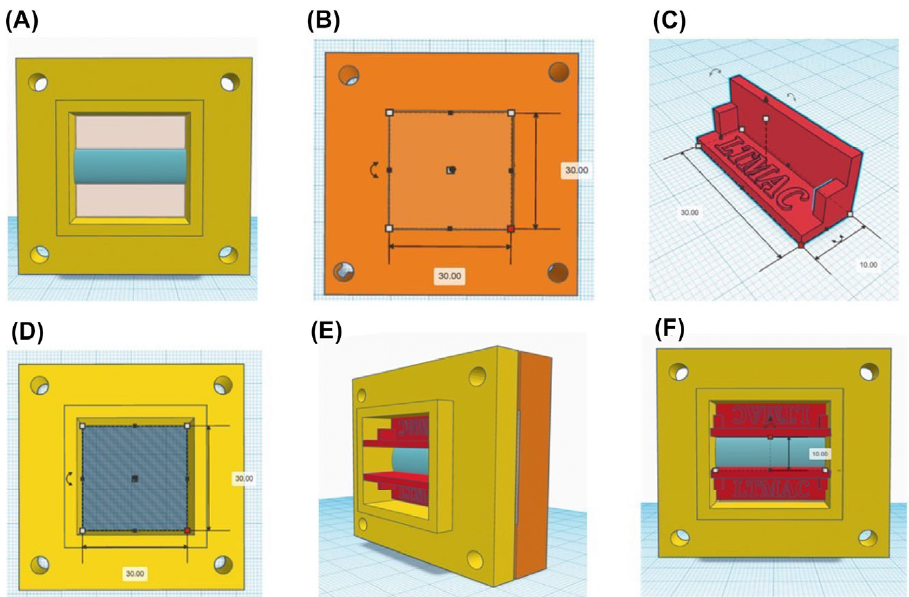
Figure 5. Virtual models of vertical permeation device parts. ( A ) There is an internal area of 9 cm 2 , where the skin is exposed; ( B ) the lower part consists of an internal area of 9 cm 2 and a depth of 4 mm, which is intended for filter paper; ( C ) templates limit the area of formulation application on the skin; ( D , E ) formulation application with the templates; ( F ) representation of the model after template